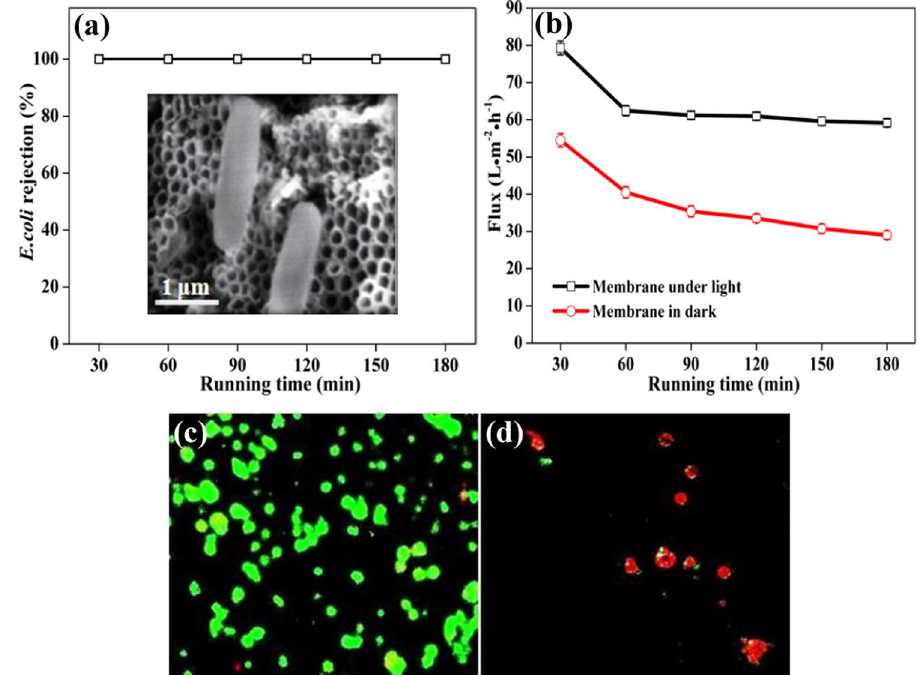
Figure 5. ( a ) The rejection of E. coli by g-C 3 N 4 /TNA membrane 3; ( b ) E. coli flux in outlet of g-C 3 N 4 /TNA membrane 3 with and without visible light irradiation; The fluorescent microscopic images of E. coli on the membrane surface ( c ) without and ( d ) with light